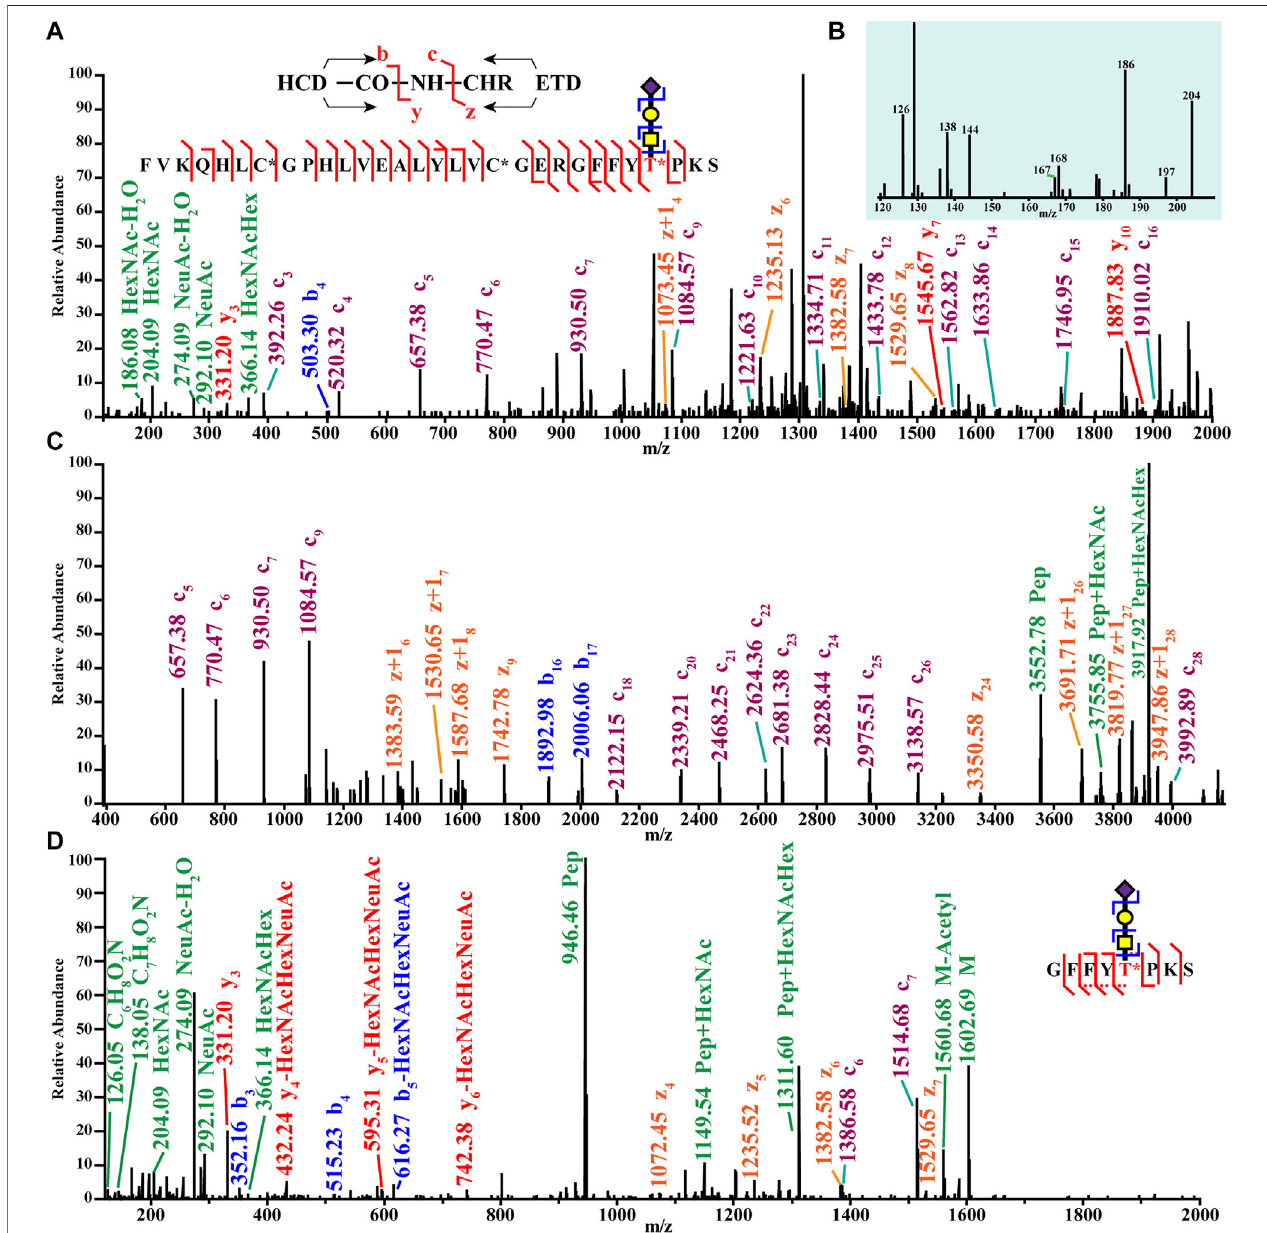
FIGURE 8 | Top-down ( A,C ) and bottom-up tandem mass spectra ( B,D ) of an O-glycoform of an insulin chain from mouse pancreatic islets. Reproduced with permission from Yu, Q., Canales, A., Glover, M. S., Das, R., Shi, X., Liu, Y., et al. (2017). Targeted Mass Spectrometry Approach Enabled Discovery of O-Glycosylated Insulin and Related Signaling Peptides in Mouse and Human Pancreatic Islets. Anal. Chem. 89, 9184 – 9191. doi: 10.1021/acs.analchem.7b01926. Copyright © 2017 American Chemical Society.